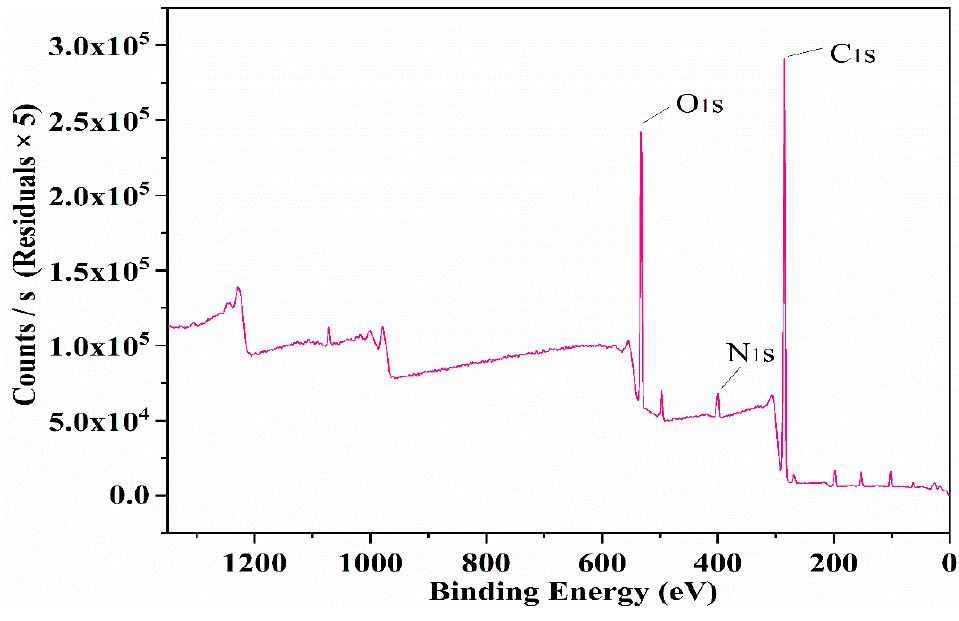
Figure 8. XPS full element scan of CMC-O-PKO-ECH.